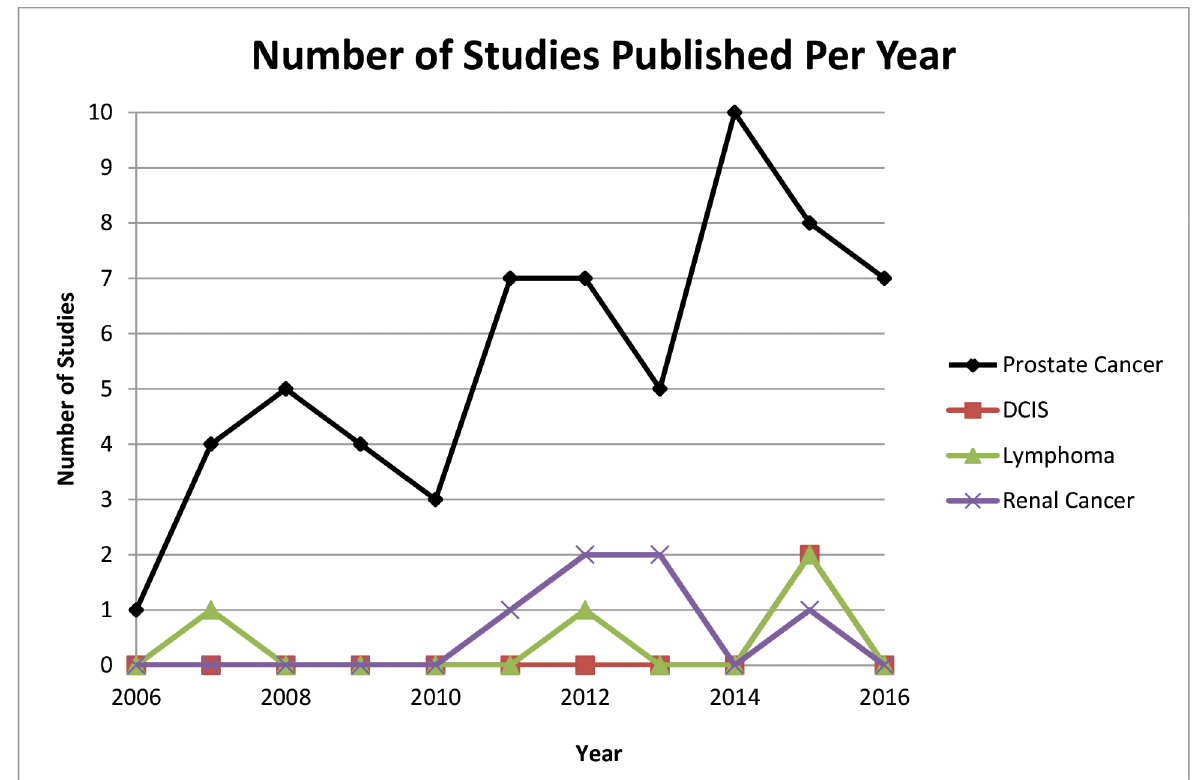
Fig 2. Studies published per year.